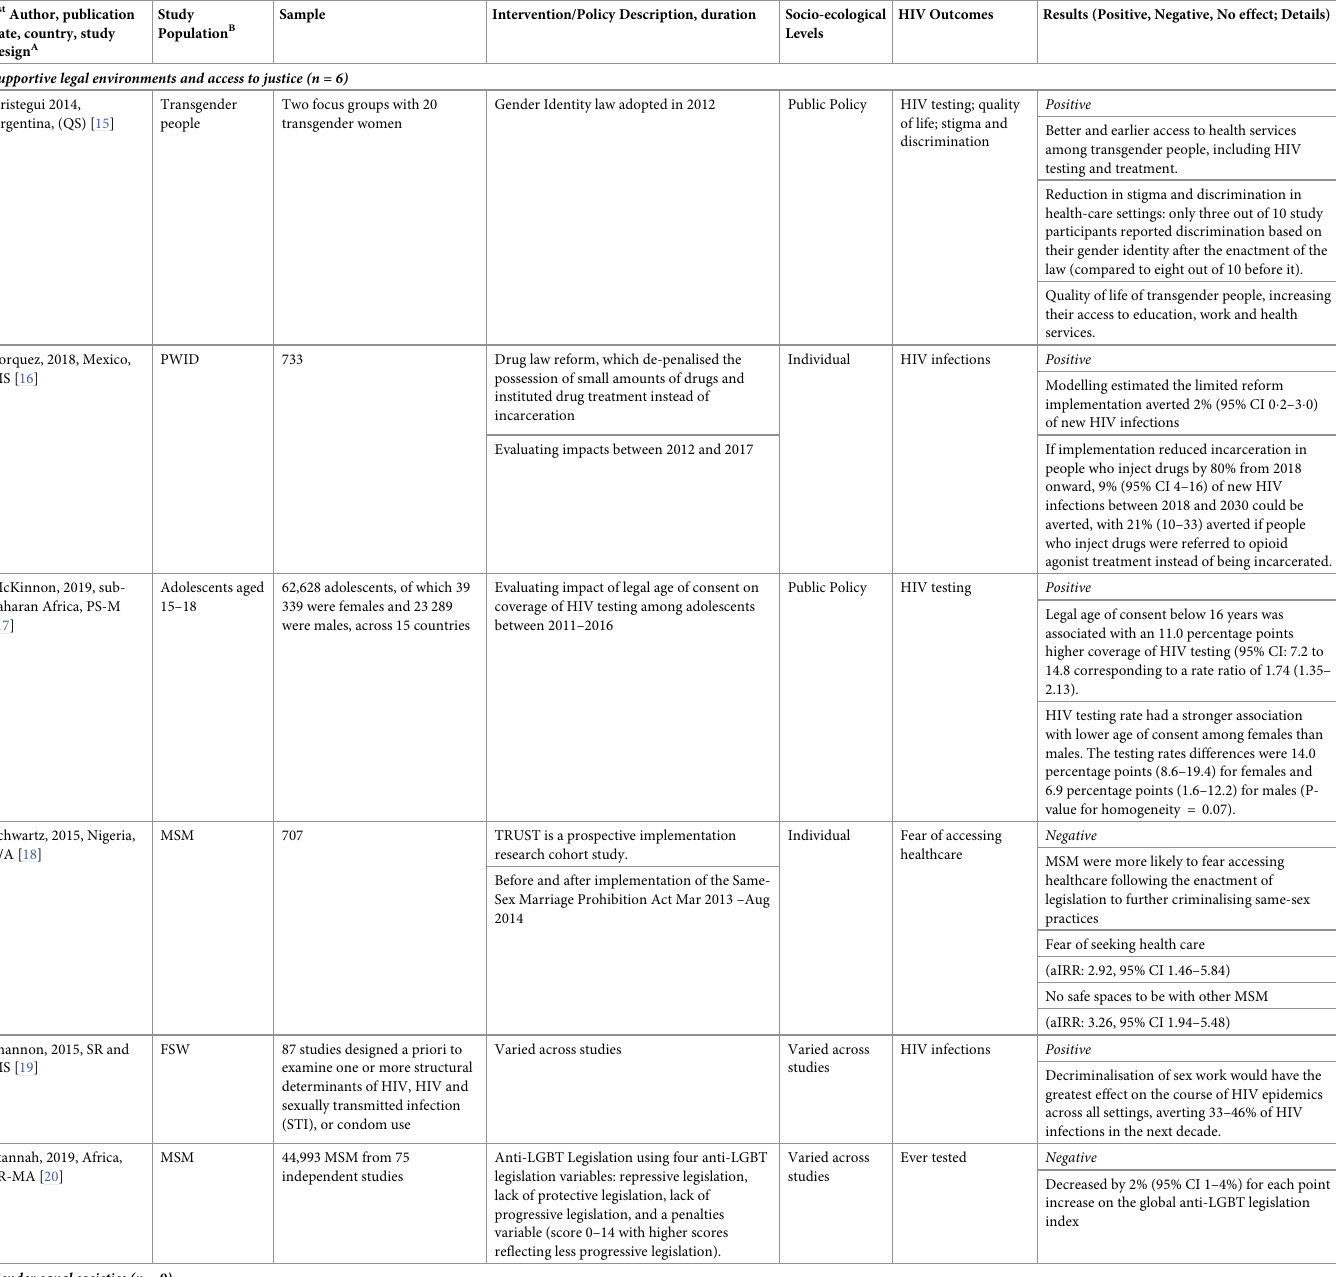
Table 1. Study and intervention characteristics, HIV outcomes assessed, and study findings by societal enabler from 30